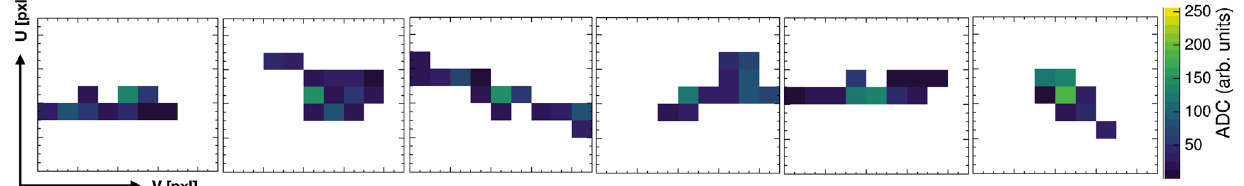
tion and results in an improved identification performance for electrons and muons. The degraded performance for the pro- tons is related to their higher energy deposition compared to the lighter particles, which gives rise to high-charge clusters resembling magnetic-monopole clusters.